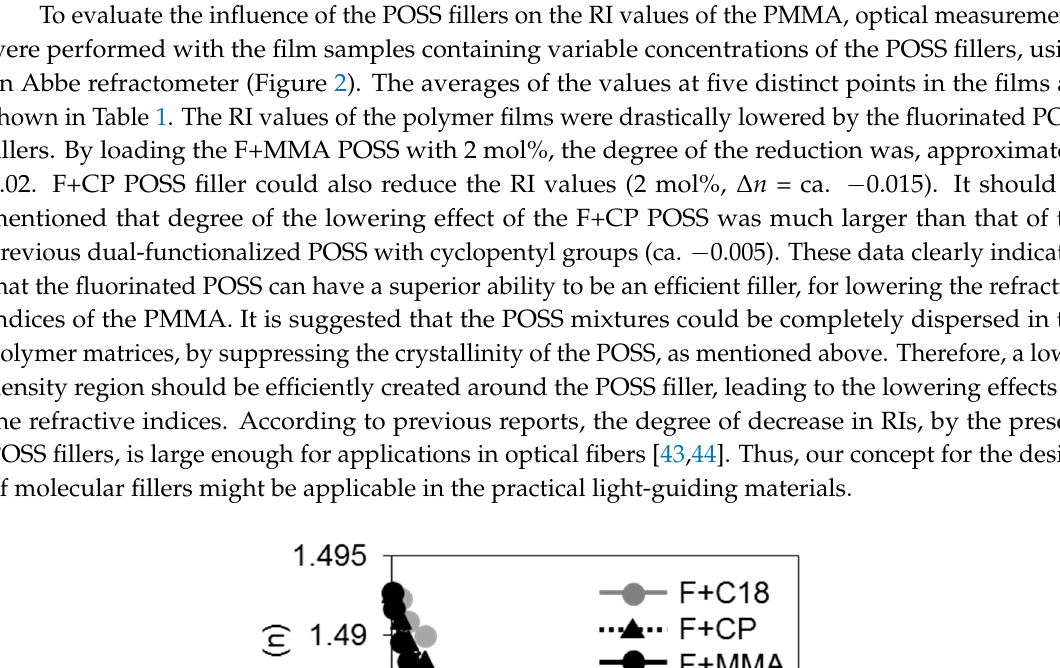
Figure 1. Appearances of the poly(methyl methacrylate) (PMMA) hybrid films with 2 mol% POSS fillers.